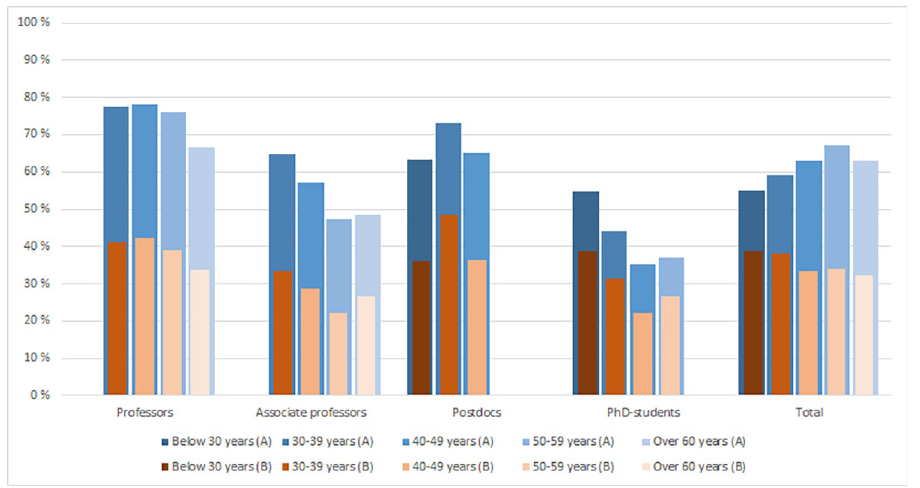
Fig 3. Proportion researchers involved in international collaboration (indicator A) and average proportion of publications with international collaboration per researchers (indicator B) by academic positions and age groups (A) (N = 5,554) � . � ) Figures are not shown for categories with less than twenty researchers.